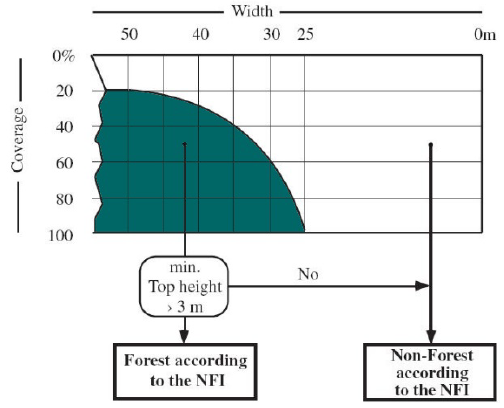
Figure 2. Forest definition based on minimum tree top height, crown coverage, and minimum width as applied in the Swiss NFI.